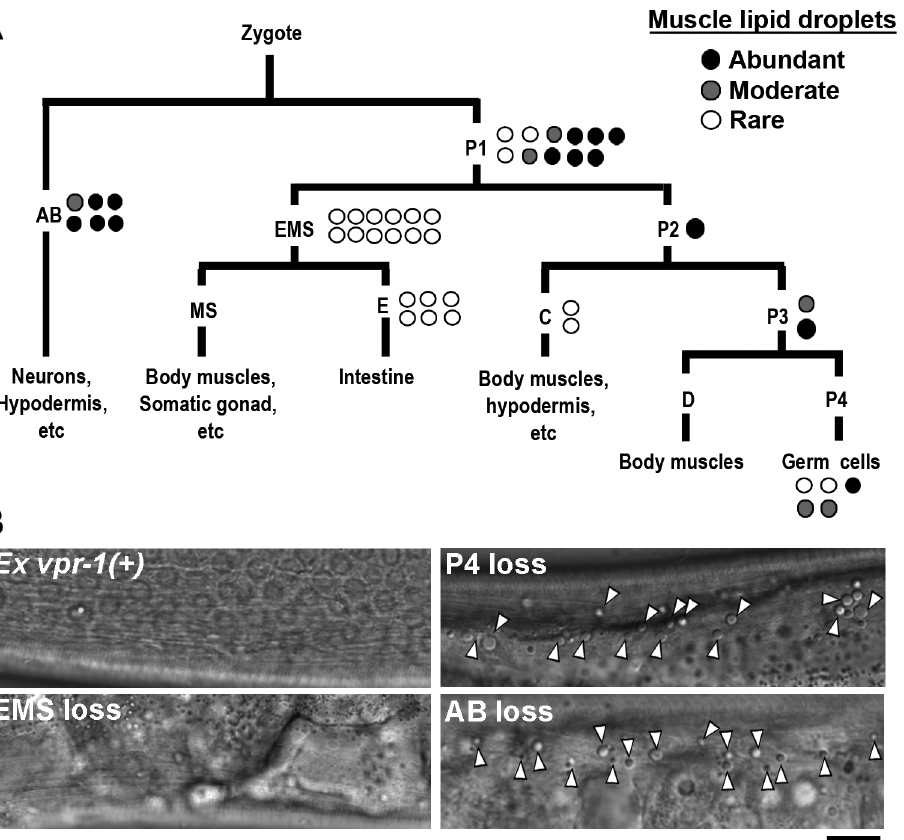
Figure 2. vpr-1 mosaic analysis. (A) Analysis of vpr-1 genetic mosaics showing the lineages of major tissues. Each circle indicates one genetic mosaic worm. Points at which the genomic copy of vpr-1( + ) was lost and the resulting phenotype are shown. (B) Representative DIC images of muscle in vpr-1(tm1411) mutant mosaic worms. Ex vpr-1( + ) indicates expression of the vpr-1 genomic locus via an extrachromosomal array. Arrowheads indicate fat droplets. Bar, 5 m m. neurons and germ cells (or their differentiation products) to